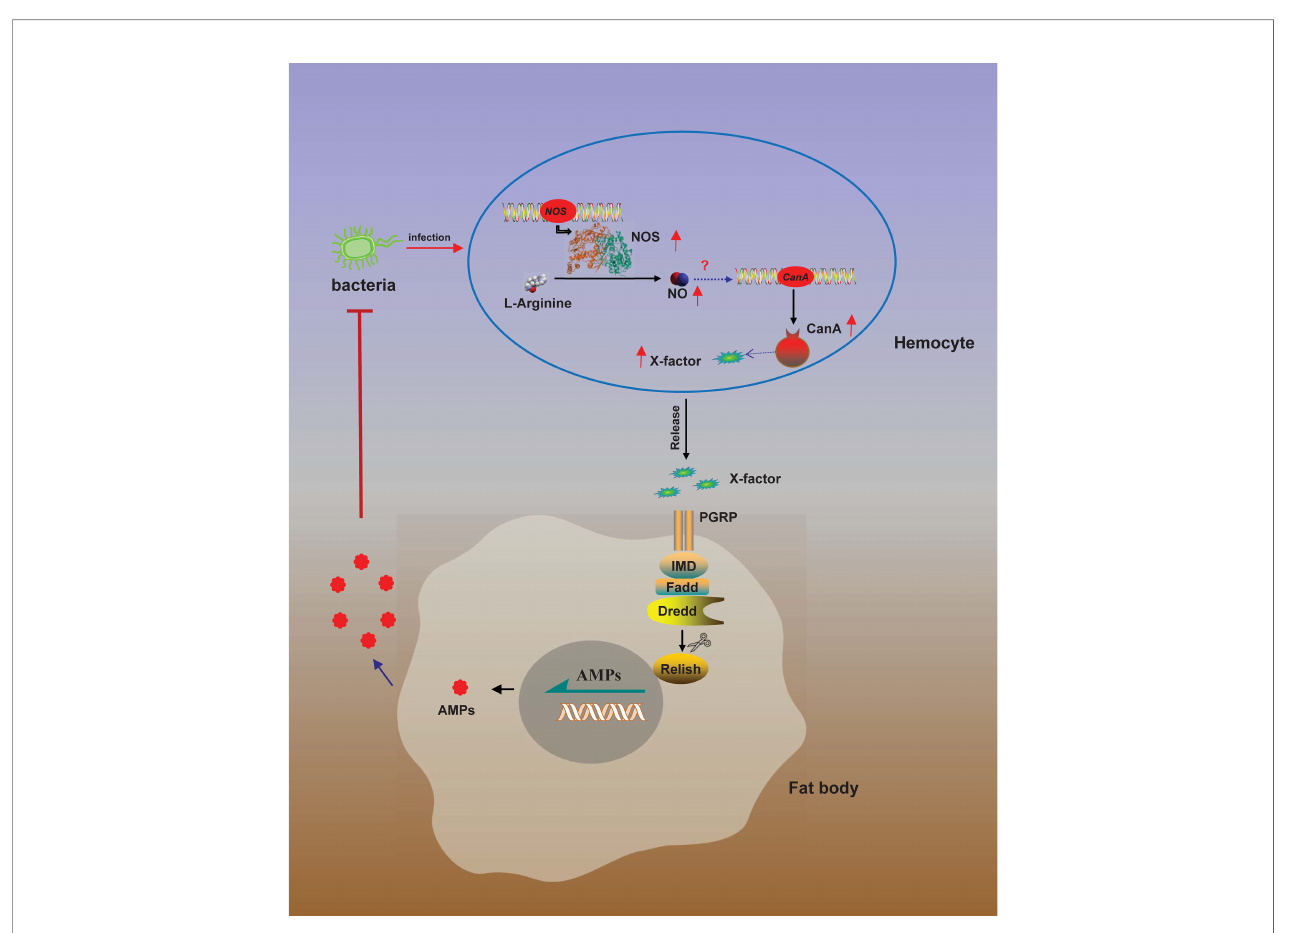
FIGURE 9 | A model for NO-regulated AMP production. Bacterial infection induces NOS expression in hemocytes to convert L-arginine to NO by NOS. NO then induces CanA expression to produce and release of an unknown factor (X) from hemocytes. Released X activates AMP expression in fat body via IMD pathway to eliminate the invading